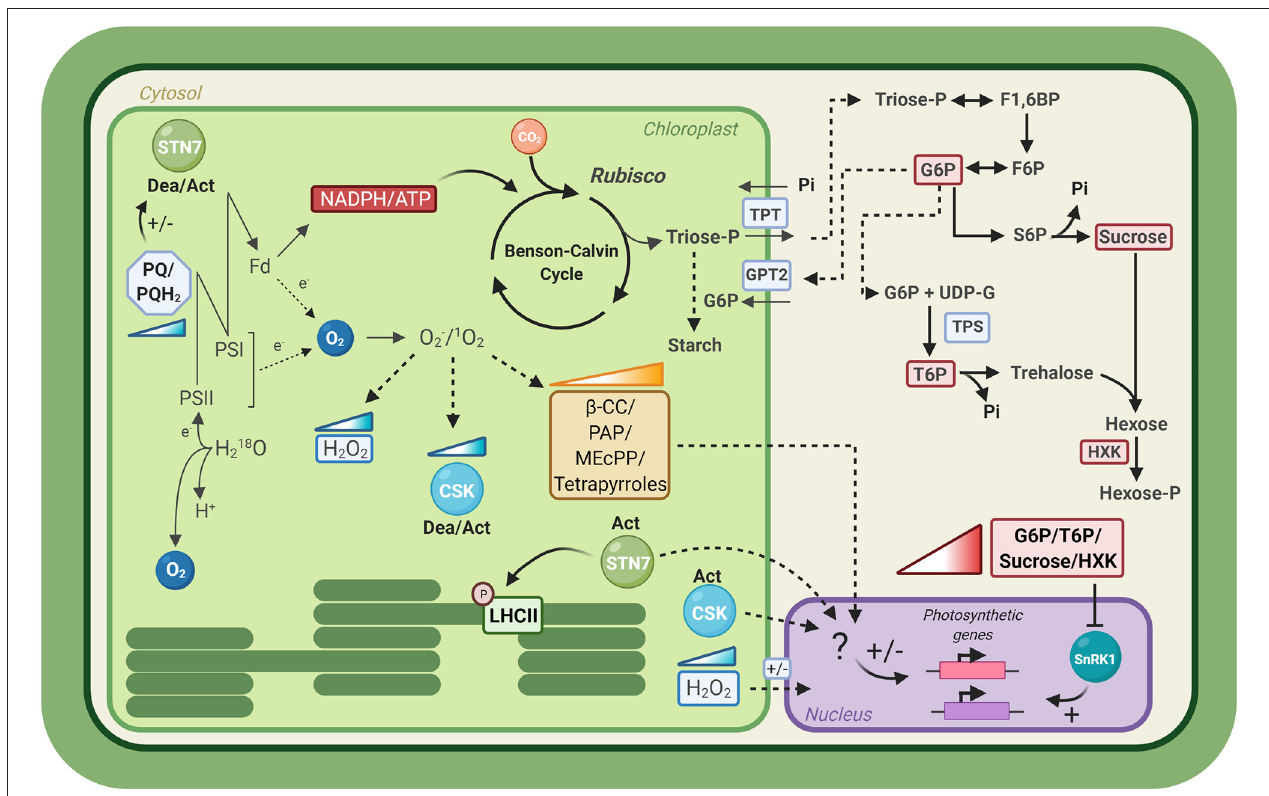
FIGURE 2 | Signals transduction pathways of long-term acclimation to fluctuating light. Schematic representation of the different putative signaling pathways involved in photosynthetic acclimation to fluctuating light, as described in section Signals Transduction Pathways for Long-Term Acclimation to Fluctuating Light. Colored gradient triangles depict accumulation of a metabolite or enzyme. LHCII, Light Harvesting Complex II; PSII, Photosystem II; PSI, Photosystem I; Fd, Ferredoxin; PQ, Plastoquinone; PQH2, Plastoquinol; STN7, STN7 kinase; CSK, Chloroplast Sensor Kinase; SnRK1, SNF1-related kinase 1 β -CC, β -cyclocitral; PAP, 3 ′ -phosphoadenosine 5 ′ -phosphate; MEcPP, methylerythritol cyclodiphosphate; TPT, Triose-phosphate transporter; GTP2, glucose 6-phosphate/phosphate translocator; G6P, glucose-6-phosphate; T6P, trehalose-6-phosphate; F6P, fructose-6-phosphate; S6P, sucrose-6-phosphate; F1,6BP, fructose-1,6-biphosphate; TPS, Trehalose phosphate synthase; HXK, Hexokinase; Dea/Act, Deactivation/Activation. Created with BioRender.com.